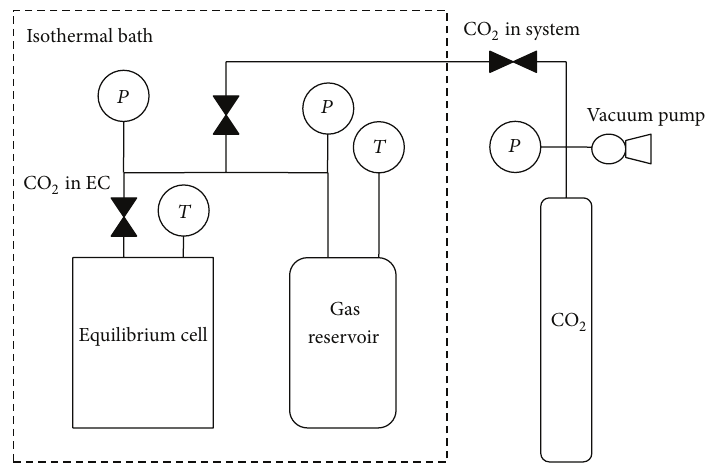
Figure 4: The pressure drop apparatus, where 𝑃 and 𝑇 correspond to pressure and temperature sensors.